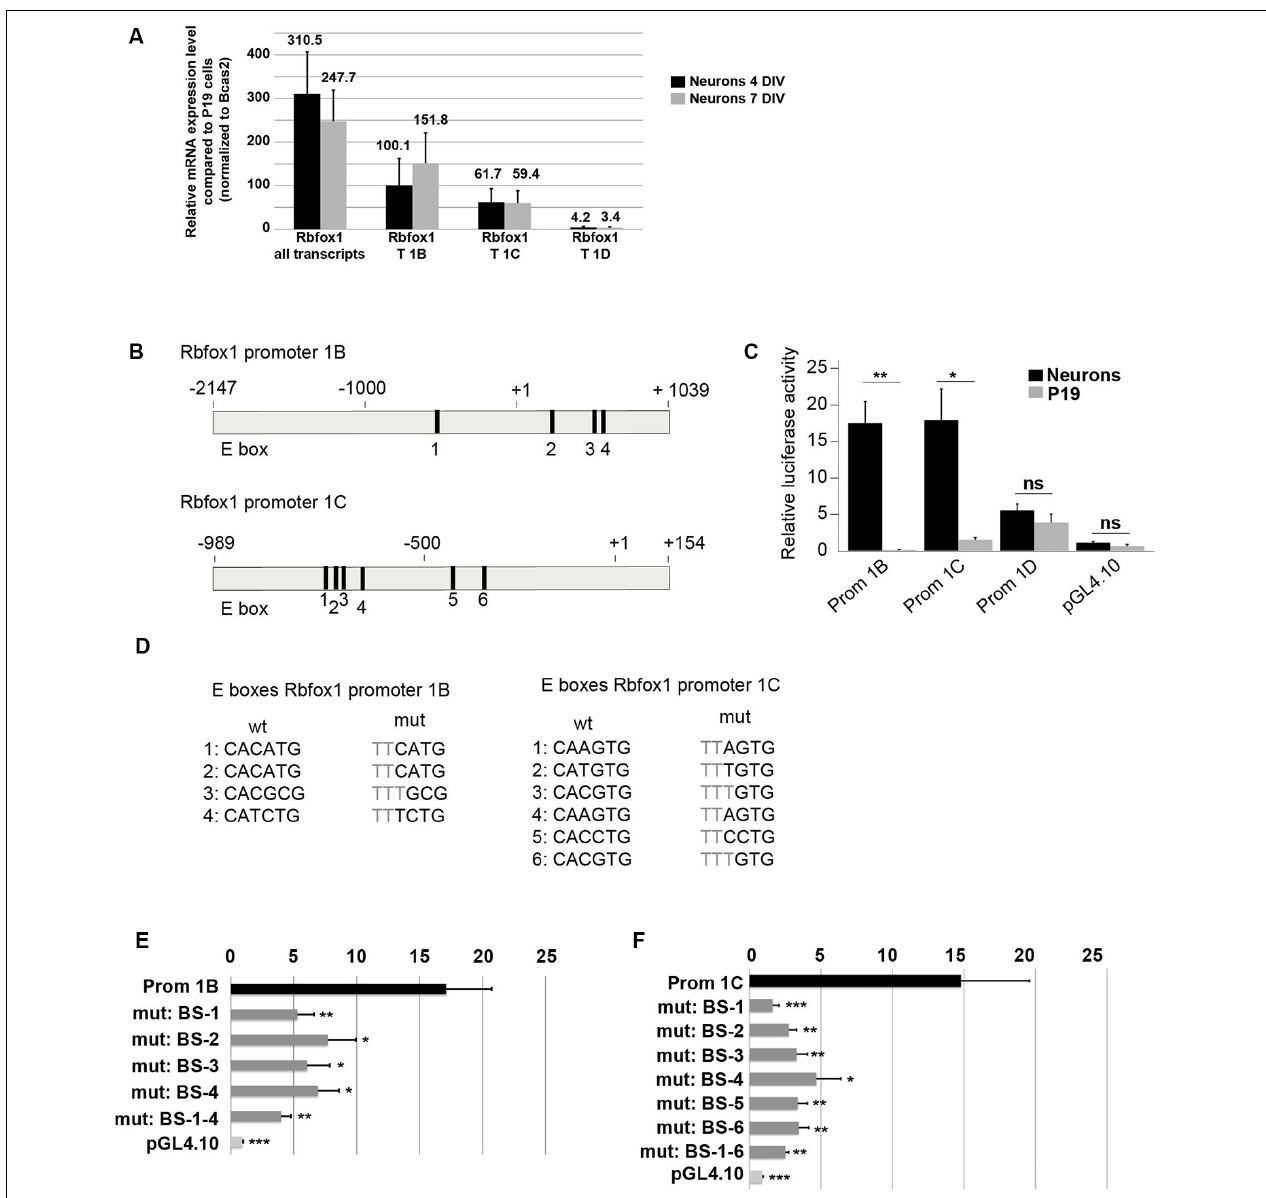
FIGURE 4 | E-boxes promote expression of Rbfox1 1B and 1C/1C.1 in neurons. (A) Expression of Rbfox1 alternative first exons in primary cortical neurons. Total RNA was isolated from primary cortical neurons that had been in culture for 4 or 7 days, and cDNA synthesis and qPCR experiments with primers corresponding to Rbfox1 exons 20/21, 1B, 1C or 1D were performed ( n = 4). (B) The scheme of the Rbfox1 1B and 1C/1C.1 upstream regulatory regions that were cloned into the pGL4.10 vector. Black boxes represent evolutionary conserved E-boxes. Numbers indicate the nucleotide position relative to the transcriptional start sites. (C) Luciferase assays were performed in primary cortical neurons and undifferentiated P19 cells to determine the promoter activities of the Rbfox1 1B, 1C/1C.1 and 1D upstream regulatory regions ( n = 8). Statistical analyses were done using student’s t -test. ns, not significant; * P < 0.05; ** P < 0.01. (D) Sequences of the wildtype and mutated E-boxes as depicted in (B) . (E,F) Luciferase assays were performed to determine the activity of the Rbfox1 1B and 1C/1C.1 upstream regulatory regions with or without mutations in all E-boxes or every single E-box ( n = 6). The standard error of the mean is indicated by black bars. Statistical analyses were done using one-way-ANOVA with Bonferroni’s multiple comparison test. * P < 0.05; ** P < 0.01; *** P <